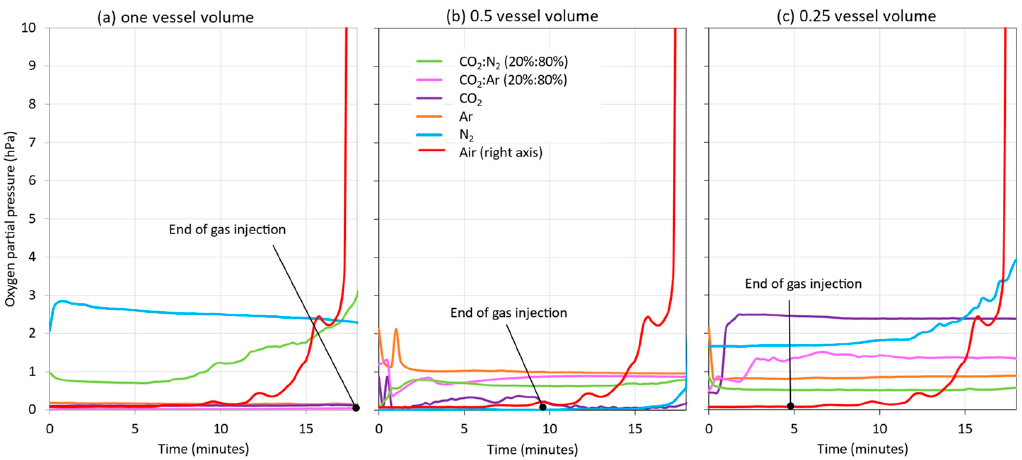
Figure 10. Influence of blanketing with different inert gases and different number of vessel volumes of gas on the DO of the wine monitored at the outlet valve of the source tank during the racking of a model wine: 1 vessel volume ( a ); 0.5 vessel volume ( b ); and 0.25 vessel volume ( c ).